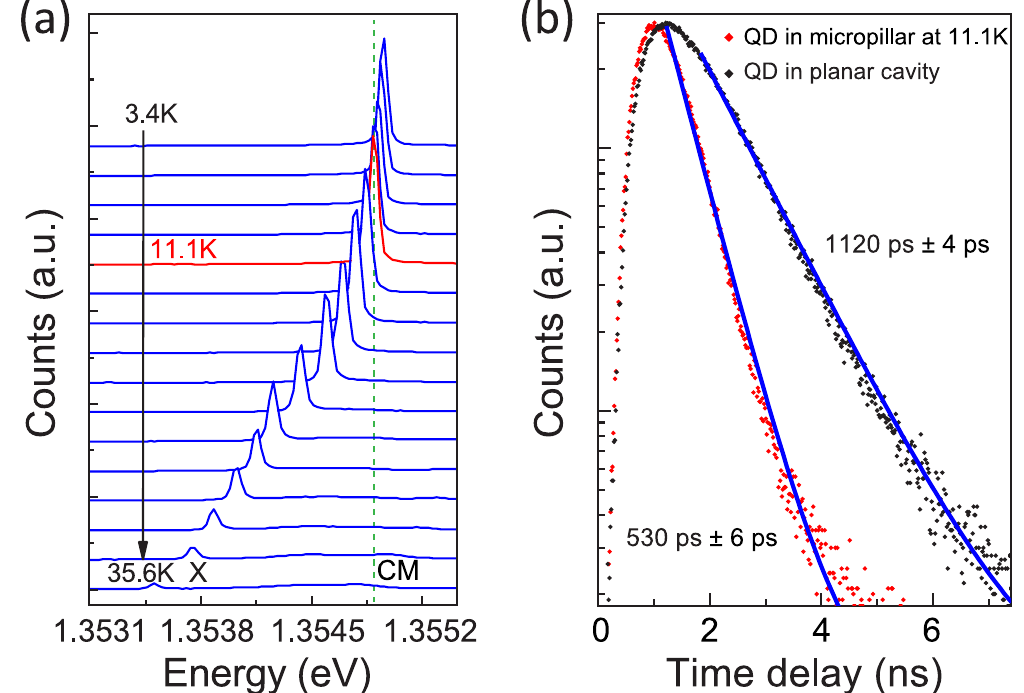
Figure 3. ( a ) Temperature dependent spectra of a micropillar with a diameter of 2 μ m, a strong enhancement on spectral resonance between fundamental mode (FM) and QD due to the Purcell effect is observed at T = 11.1 K. ( b ) Time resolved measurements of the QD under above-barrier excitation (780 nm) before fabrication (in planar structure) and in the micropillar cavity at the temperature of 11.1